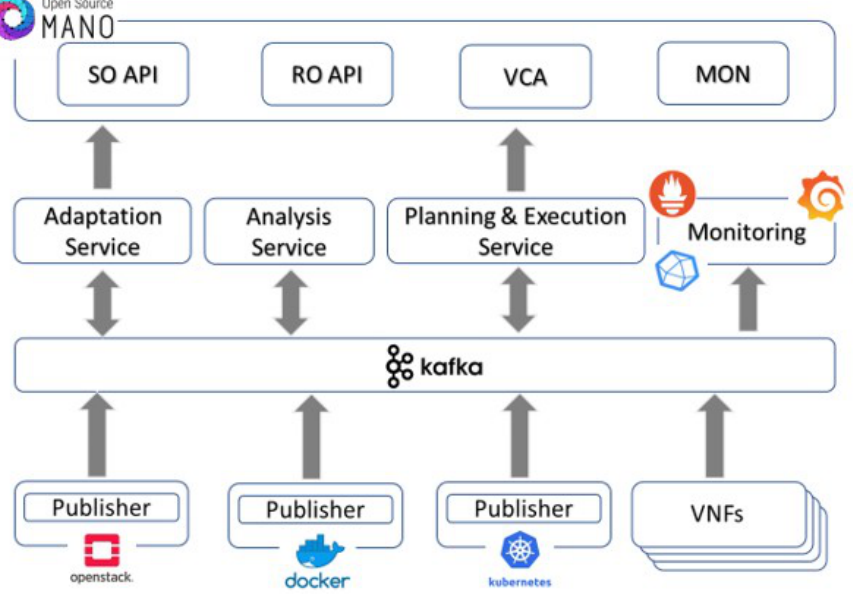
Figure 1. Monitoring and analysis